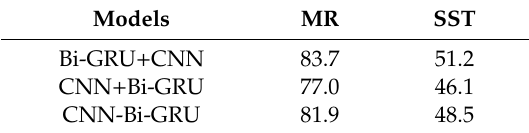
Table 3. Test accuracies (%) of di ff erent combinations of Bi-GRU and CNN. Models